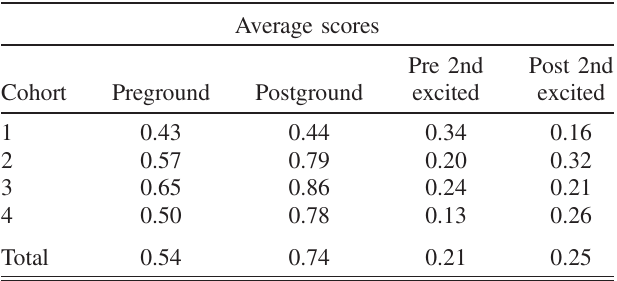
TABLE I. Average scores using the 0, 0.5, 1 grading scheme.